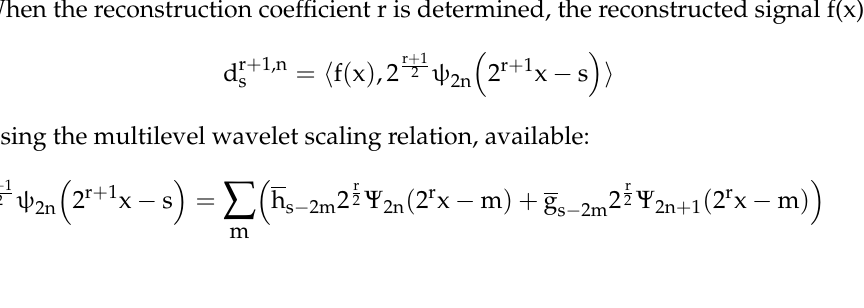
Figure 5. Flow chart of the self-matching wavelet reconstruction and decoding algorithm.